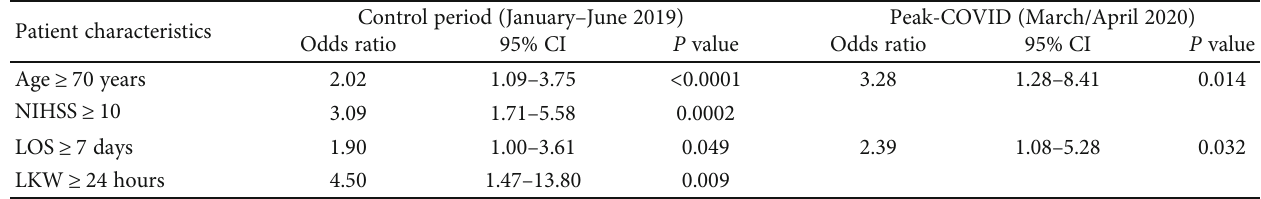
Table 4: Logistic regression models for in-hospital mortality during the control and 2020 Peak-COVID time periods. Patient